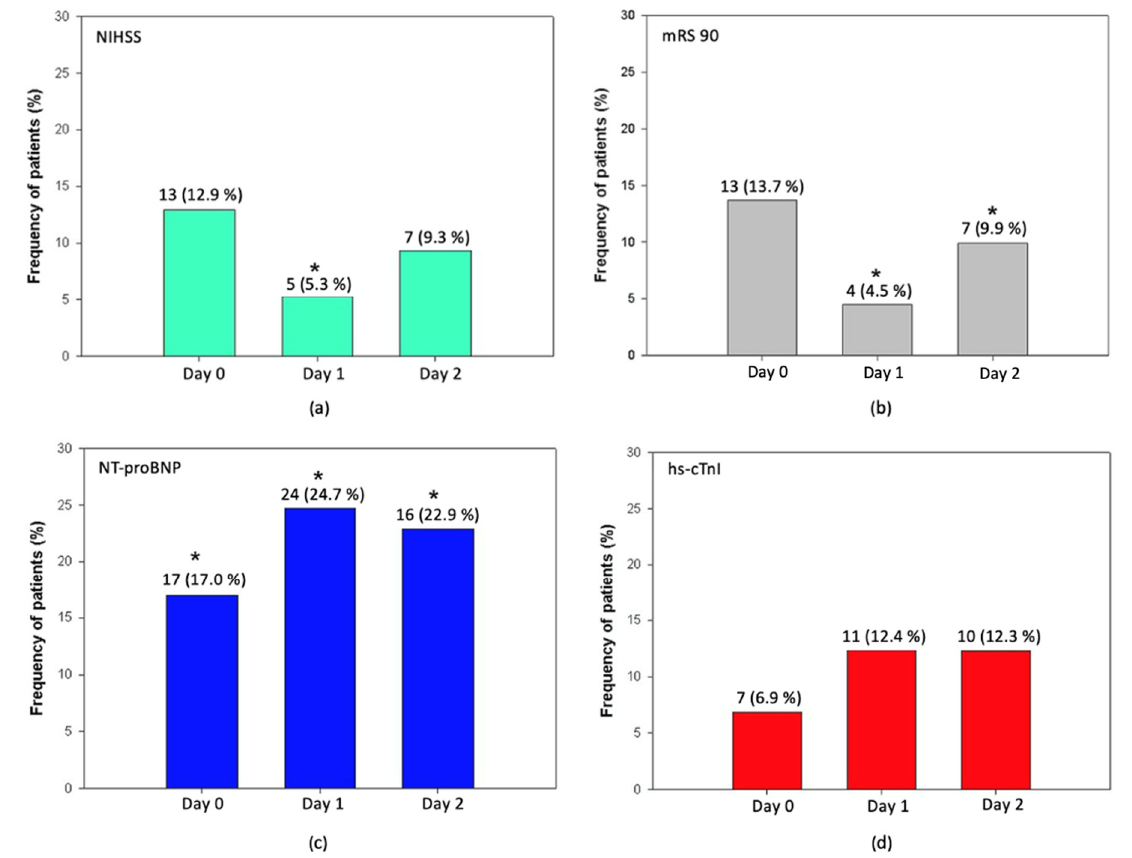
Figure 3. Relationship between lower TRAIL level (< 64 pg/mL) with markers of myocardial injury, stroke severity, and functional outcome in AIS. ( a ) relationship between lower TRAIL and moderate to severe stroke (NIHSS 16–42); ( b ) relationship between lower TRAIL and worse functional outcome or death (mRS at 90 day 5–6). ( c ) relationship between lower TRAIL and NT-proBNP elevation >125 pg/mL; ( d ) relationship between lower TRAIL and hs-cTnI elevation >53 pg/mL; The categorical values are given as frequencies and respective percentages. * Represents significant